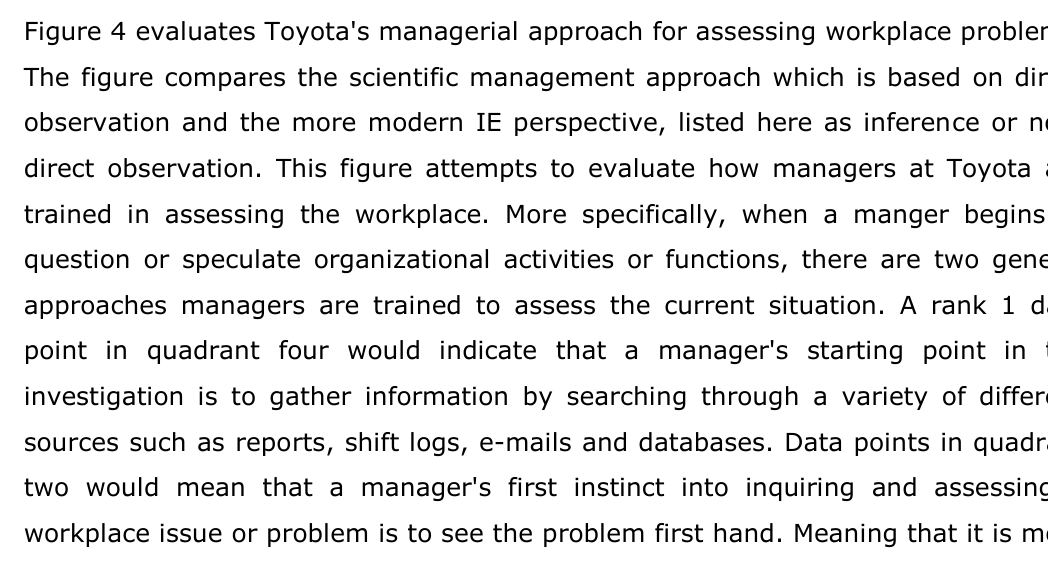
Figure 4 evaluates Toyota's managerial approach for assessing workplace